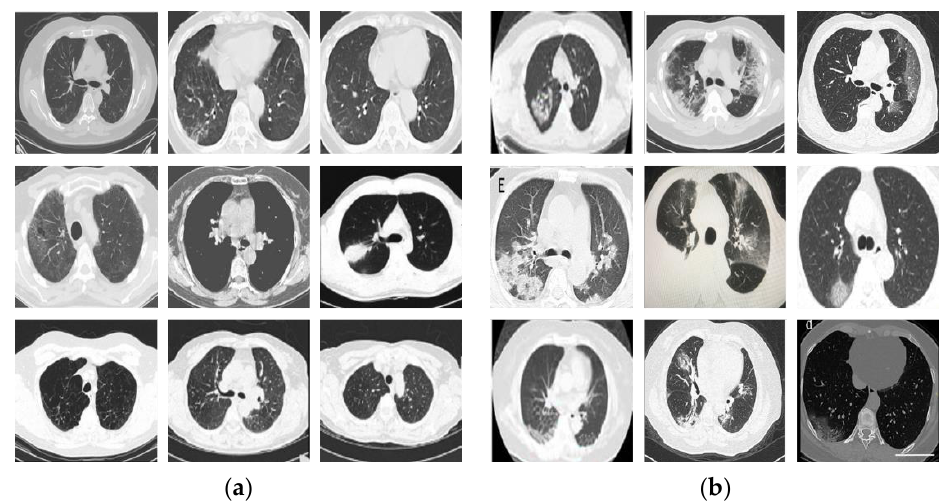
Figure 3. Visual illustration of a few example chest CT slices of COVID-19 ( a ) negative and ( b ) positive cases. The positive data samples mainly include consolidation, bilateral, ground-glass opacity, and pleural effusion.